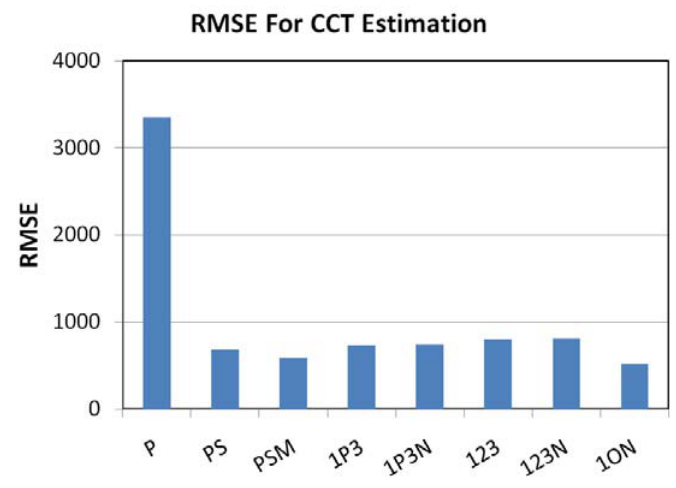
Figure 23. RMSE values for CCT estimation.